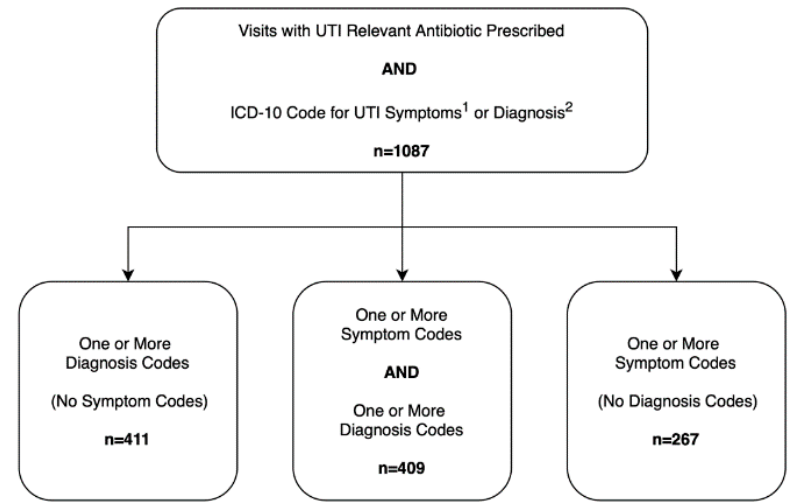
Figure 1. ICD-10 based algorithms for urinary tract infection visits. 1 Symptom codes include pain associated with micturition [R30] and dysuria [R30.0]. 2 Diagnosis codes include cystitis [N30] and